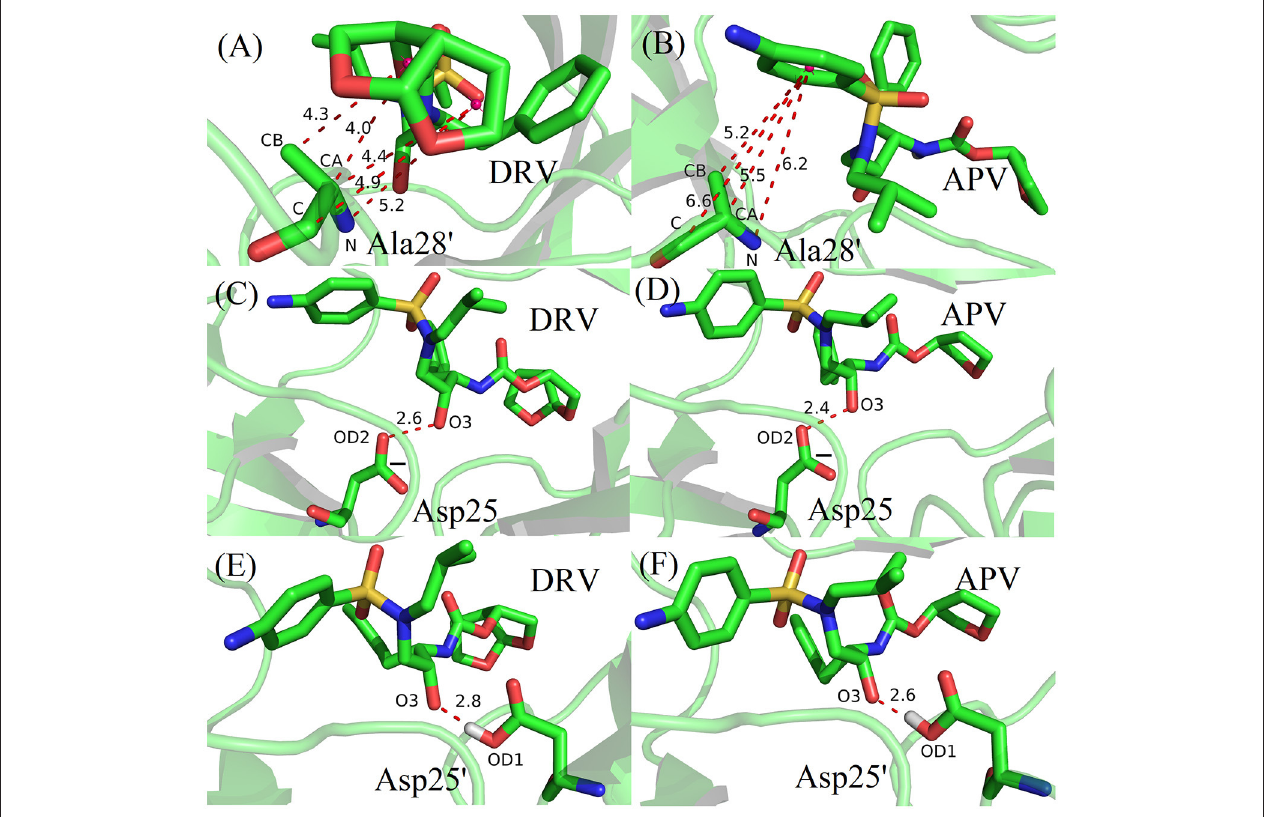
FIGURE 7 | The geometrical positions of Ala28 ′ , Asp25/Asp25 ′ and two inhibitors based on the lowest potential energy structure from MD trajectory. (A) Ala28 ′ residue in DRV-PR1. (B) Ala28 ′ residue in APV-PR1. (C) Asp25residue in DRV-PR2. (D) Asp25 residue in APV-PR2. (E) Asp25 ′ residue in DRV-PR2. (F) Asp25 ′ residue in APV-PR2.